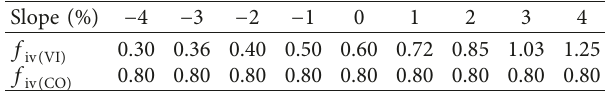
Table 1: Slope related with f condition). Slope (%)